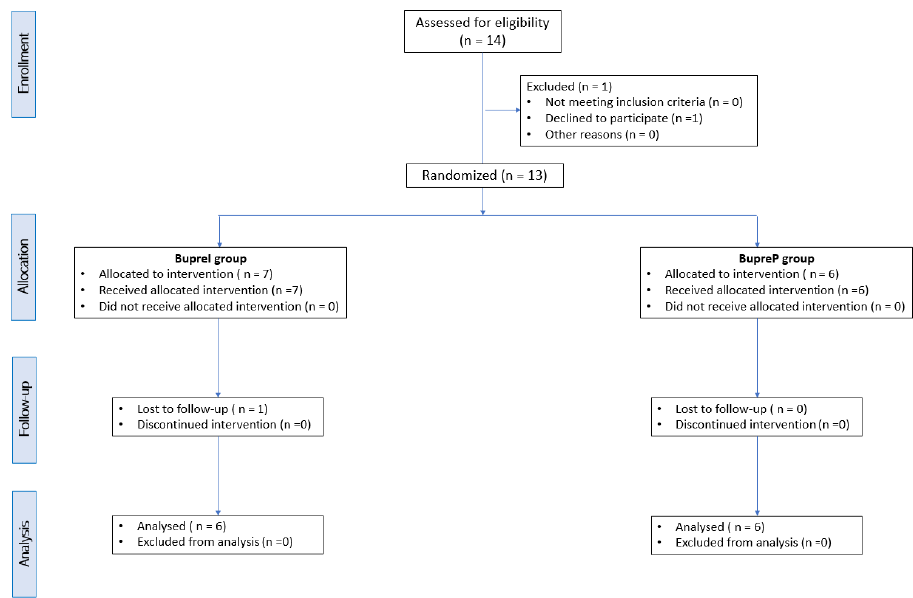
Figure 2. Consolidated Standards of Reporting Trials (CONSORT) flow diagram for dogs included in the study. Table 2. Mean ± SD of weight, age, and duration of surgery and anesthesia in both groups. The sedation score (SS) was compared between the two groups 15 min before the induction (15 min after the administration of buprenorphine in BupreI group). * p < 0.05 .